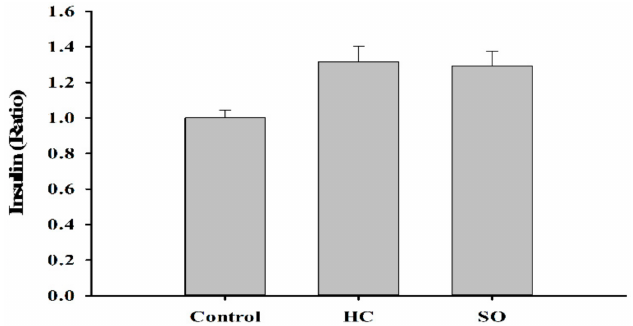
Figure 7. Insulin level in T2DM model rats after 28 days of treatment. No significant difference was found between the control-treated group by one-way ANOVA.